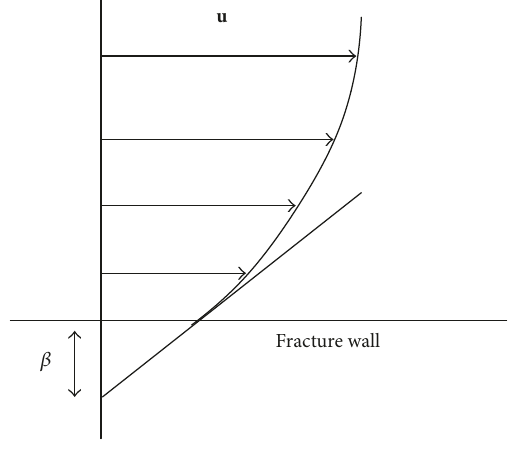
Figure 3: Definition of the slip length.